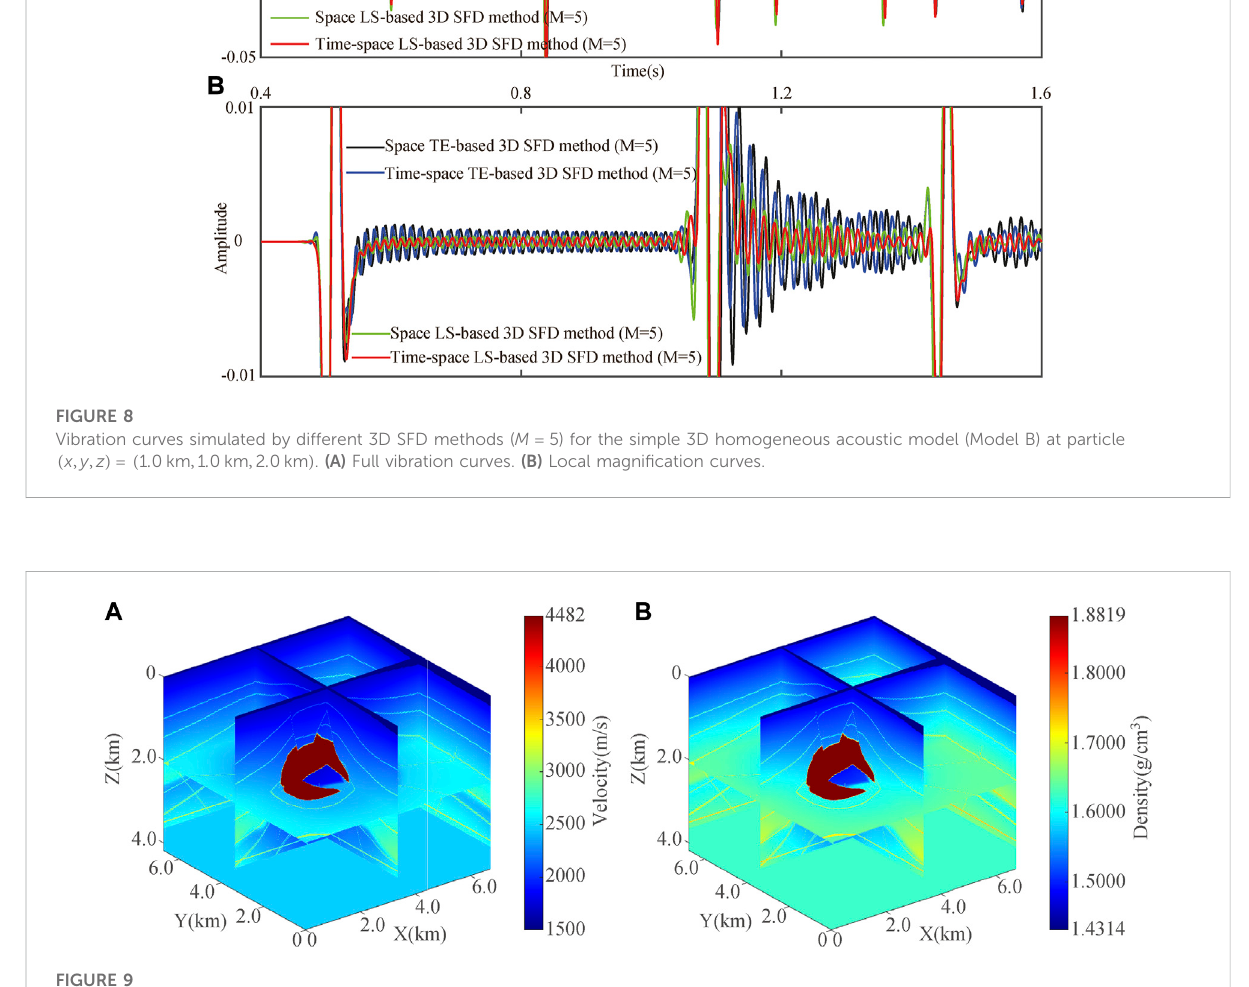
FIGURE 9 3D SEG/EAGE salt model. (A) Velocity. (B)